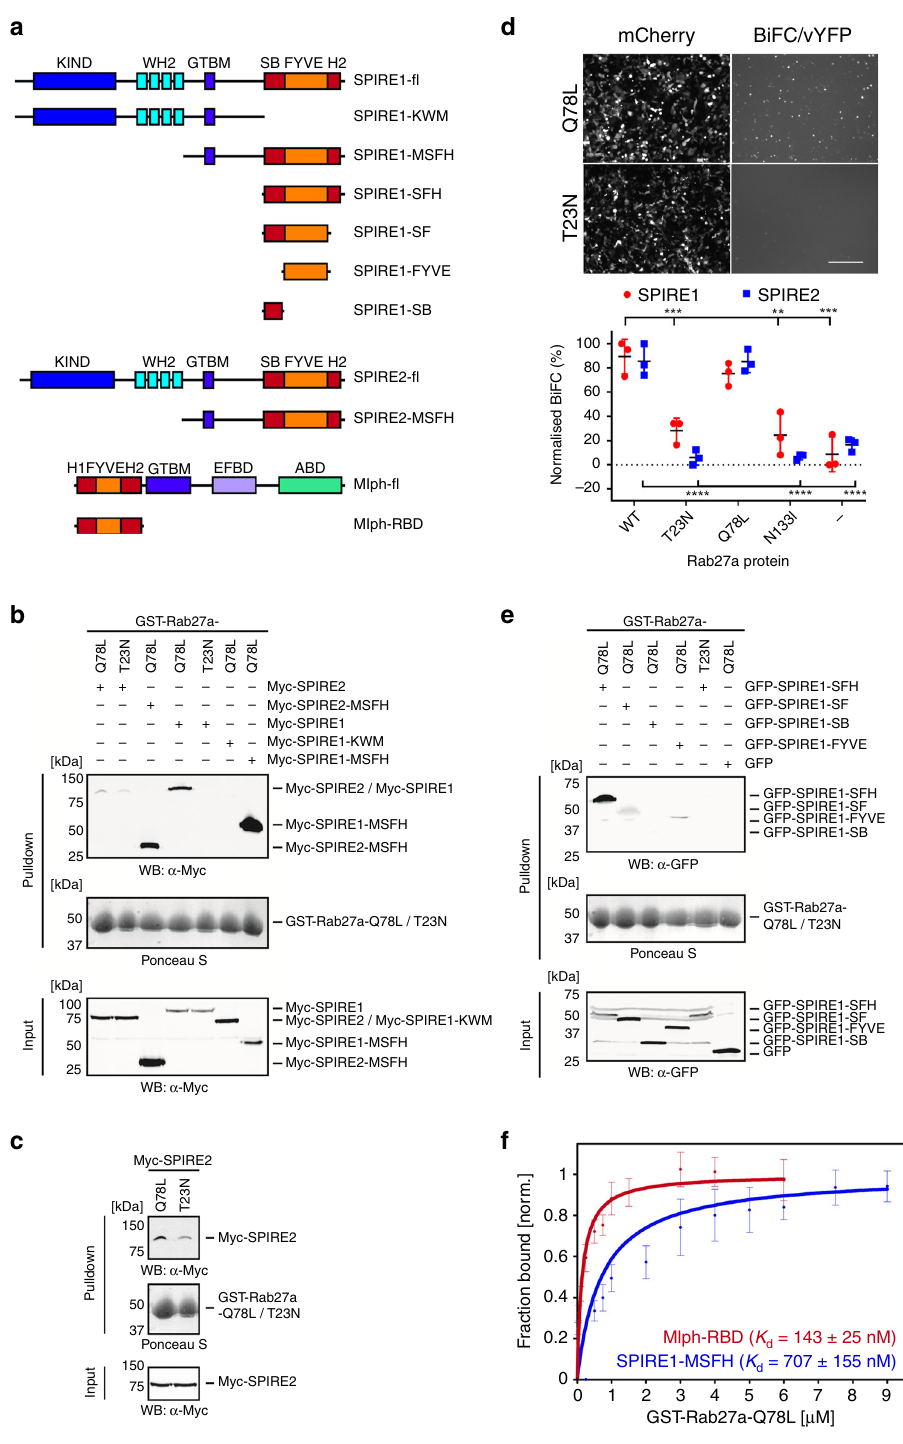
However, as seen for SPIRE1-KW and SPIRE2, in a signi fi cant proportion of cells expressing SPIRE1 E548K melanosomes were hyper- rather than uniformly dispersed, as seen for intact SPIRE1 (Fig. 4b, c; mean % of cells with HD melanosomes = 56.85 ± 1.985). Also spots of SPIRE1 E548K protein, like SPIRE2, were less frequently associated with melanosomes compared with wild-type SPIRE1 (Supplementary Fig. 5e arrows). Secondly, we investi- gated the functional effect of tethering the active SPIRE2 (KW) fragment to melanosomes, by expressing it as a fusion to the melanosome-targeted, non-functional, Rab27a SF1F4